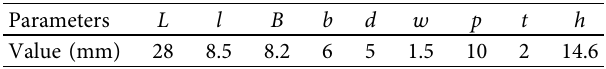
Figure 6: Variation of modal frequencies with main structural parameters of the stator. (a) Slot depth l . (b) Slot width w . (c) Stator length of the middle part d . Table 1: Structural dimension parameters of degenerate stator.